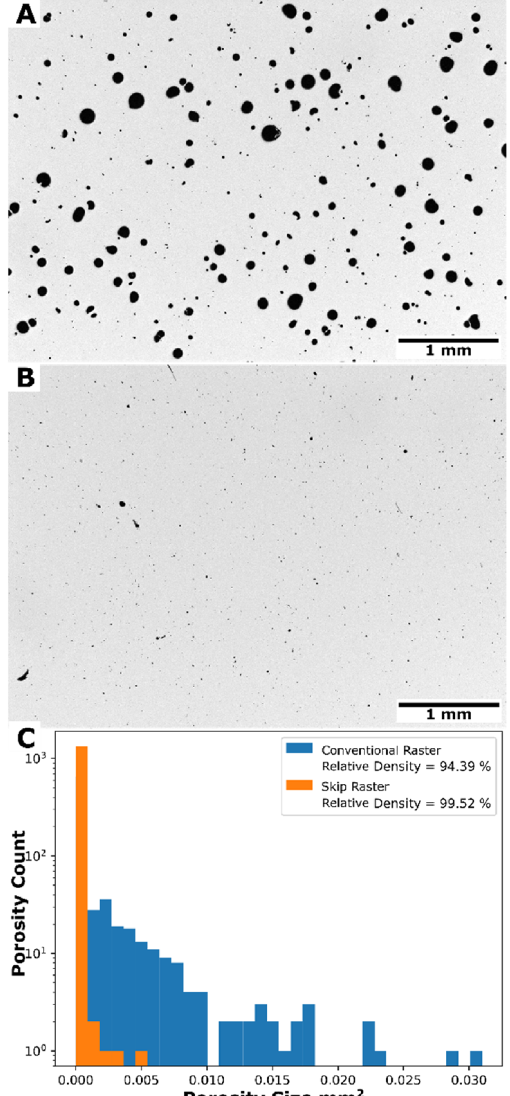
Figure 3. Comparison on Conventional ( A ) and Skip raster ( B ) for the hypereutectic alloy. With ( C ) being a comparison of the two relative